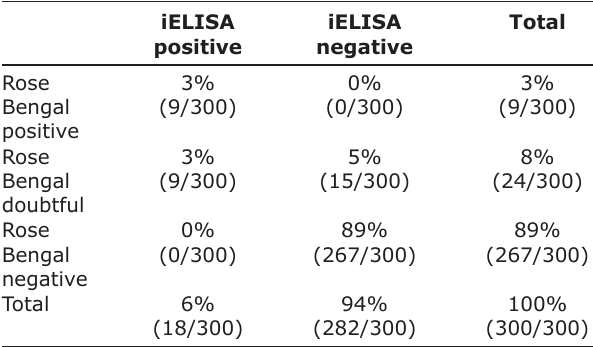
Table-1: Test result for brucellosis on 300 sheep serums collected in the Province of Bam in Burkina Faso, 2021.